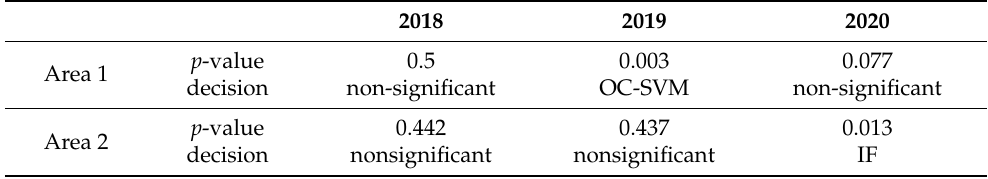
Table 3. Comparison of kappa values assigned to IF and OC-SVM models according to a 5% signifi- cance